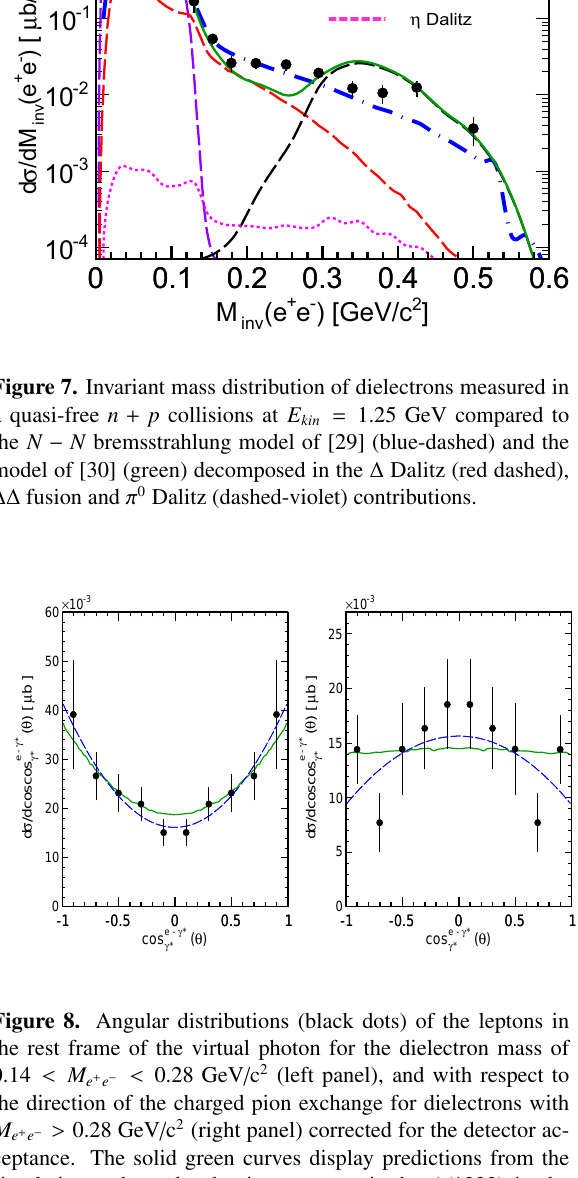
with z axis fixed along the direction of the